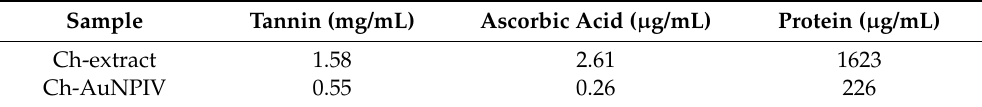
Table 2. Concentration of tannins, ascorbic acid and protein in the aqueous extract of Chaga and Ch-AuNPIV. Sample Tannin (mg/mL) Ascorbic Acid ( µ g/mL) Protein ( µ g/mL) Ch-extract 1.58 2.61 1623 Ch-AuNPIV 0.55 0.26